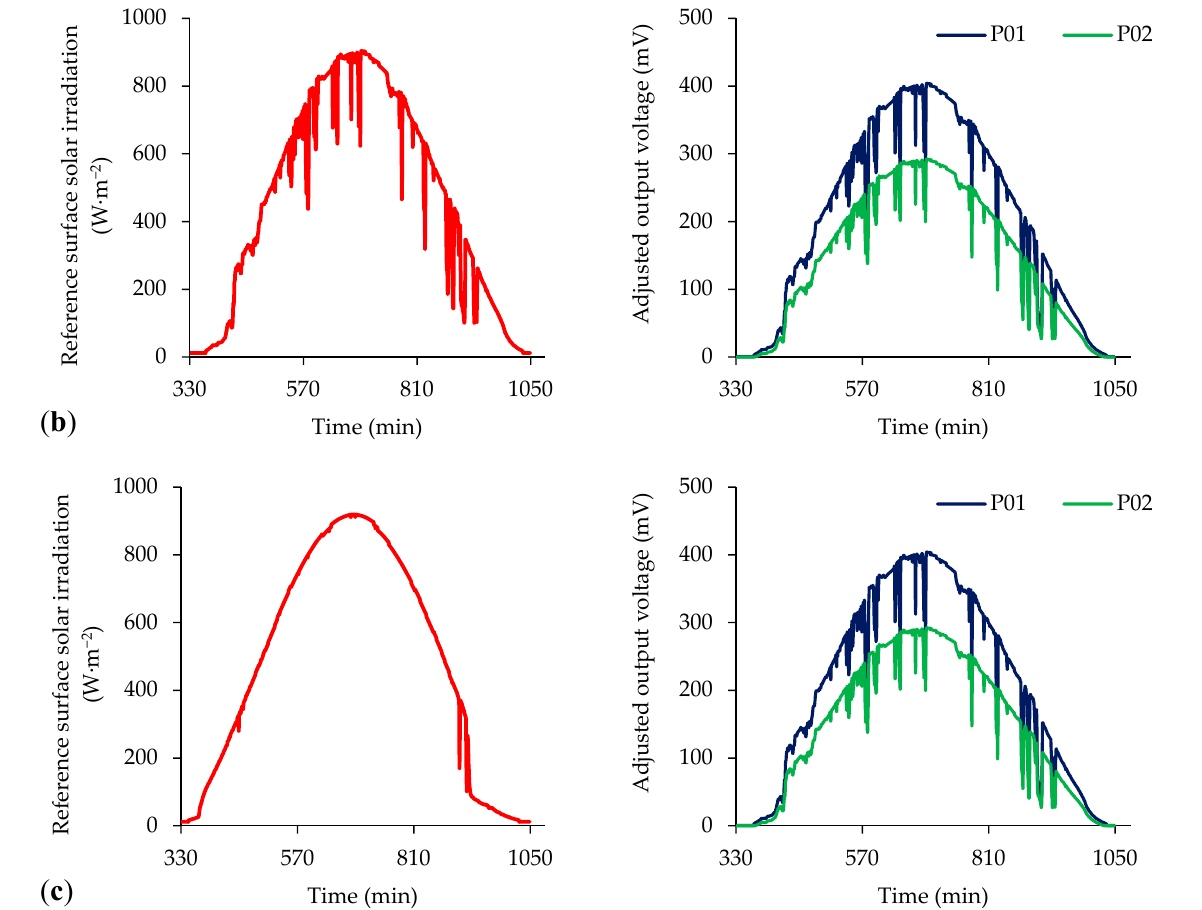
Figure 10. Reference surface solar irradiation (W · m − 2 ) and voltage (mV) time series at a sensor output for low ( a ); moderate ( b ) and high ( c ) transmittance conditions.